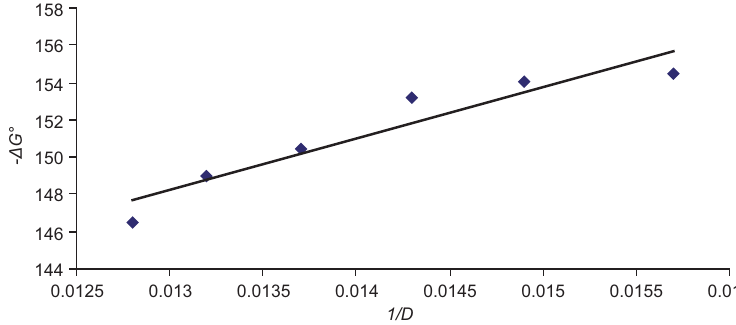
Figure 2 - Δ G ° vs. 1/ D for ( x ) water + (1 - x ) ethanol at 25 °